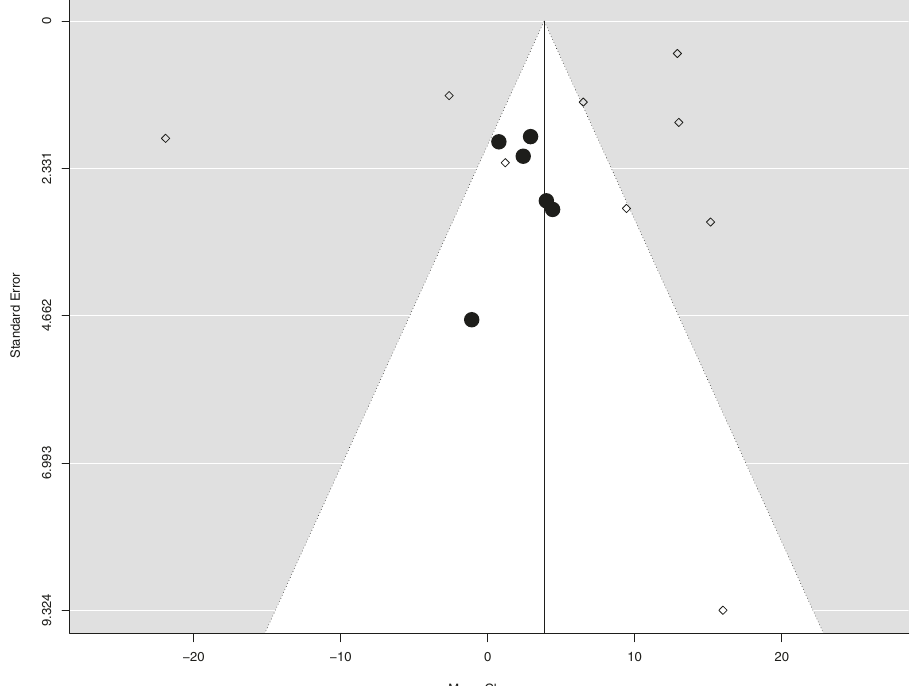
Fig. 5 Publication bias assessment with a funnel plot. In the presented graphic dispersion, each study is marked according to its risk of bias, evaluated according to QUADAS-2 tool. Studies with risk of bias are represented by diamonds ( ) and without risk of bias by circles (